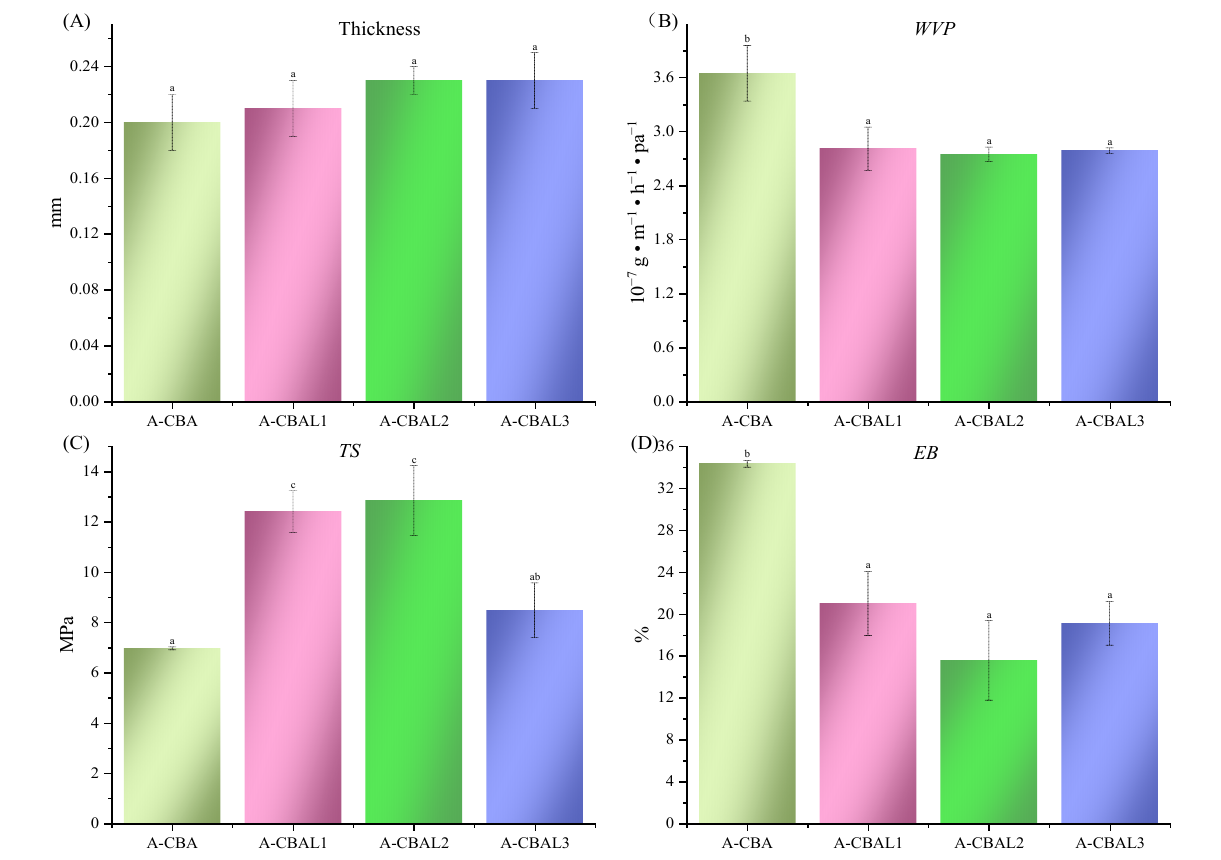
Figure 3. Thicknesses ( A ), WVP values ( B ), and mechanical properties with TS ( C ) and EB values ( D ) of the bi-layer films. Characters represent a significant difference ( p < 0.05).